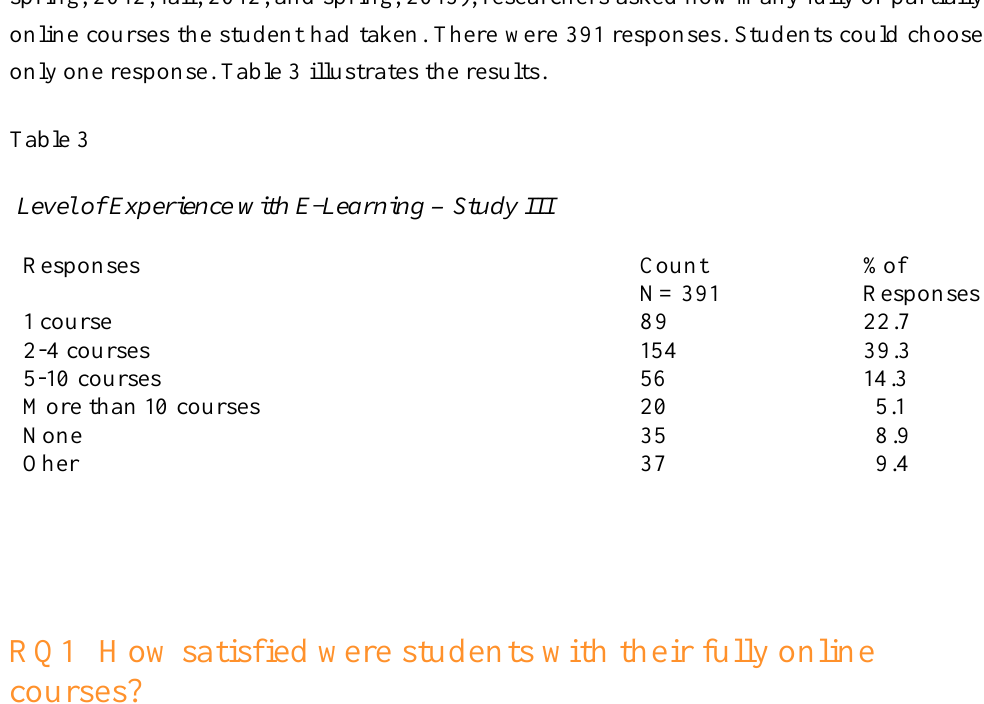
Level of Experience with E-Learning – Study